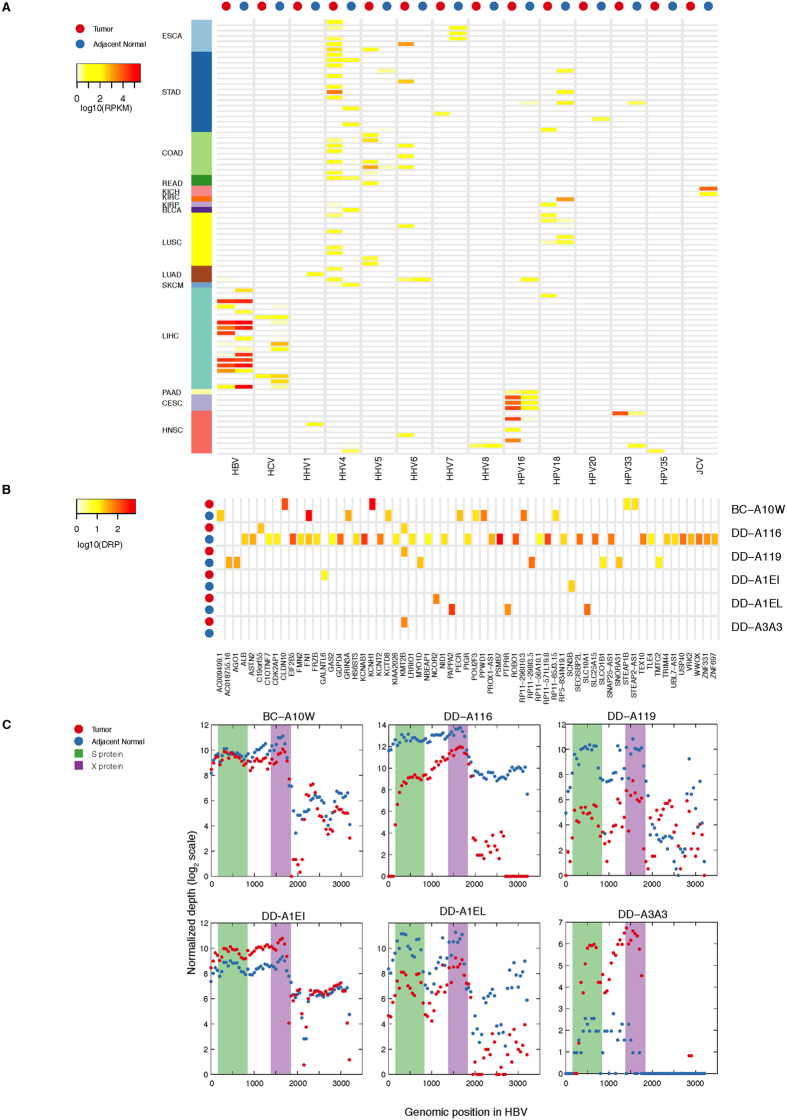
(A) Comparison of virus abundance in 81 tumor-adjacent normal pairs across 15 cancer types, with inclusion based on either the tumor or normal tissue showing a virus signature (RPHM ≥ 5). Red and blue denote tumor and normal samples, respectively, with cancer types represented by the standard color palette. Virus abundance is quantified by a white (zero) to red (maximum) continuum. (B) Comparison of HBV integration sites for six tumor-adjacent normal pairs. In six tumor/adjacent normal pairs, both tumor and normal samples have HBV abundance RPHM ≥ 100. The color bar shows the number of discordant read pairs (DRP) in log10 scale. Two recurrent sites, FN1 and KMT2B, are found in adjacent normal and tumor samples, respectively. (C) The comparison of HBV gene expression in 6 tumor-normal pairs. For a direct comparison, we use the normalized depth (see Methods) to quantify the gene expression.